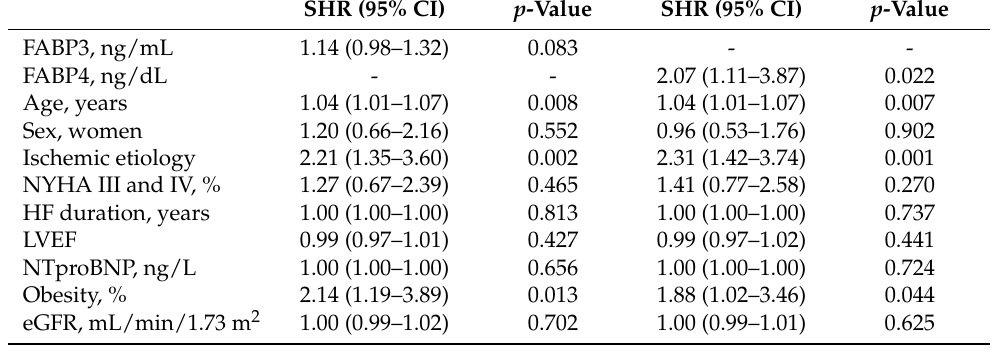
Table 4. Competitive risks analysis for the FABP3 and FABP4 concentrations and cardiovascular mortality and/or admission for heart failure in subjects with T2D.